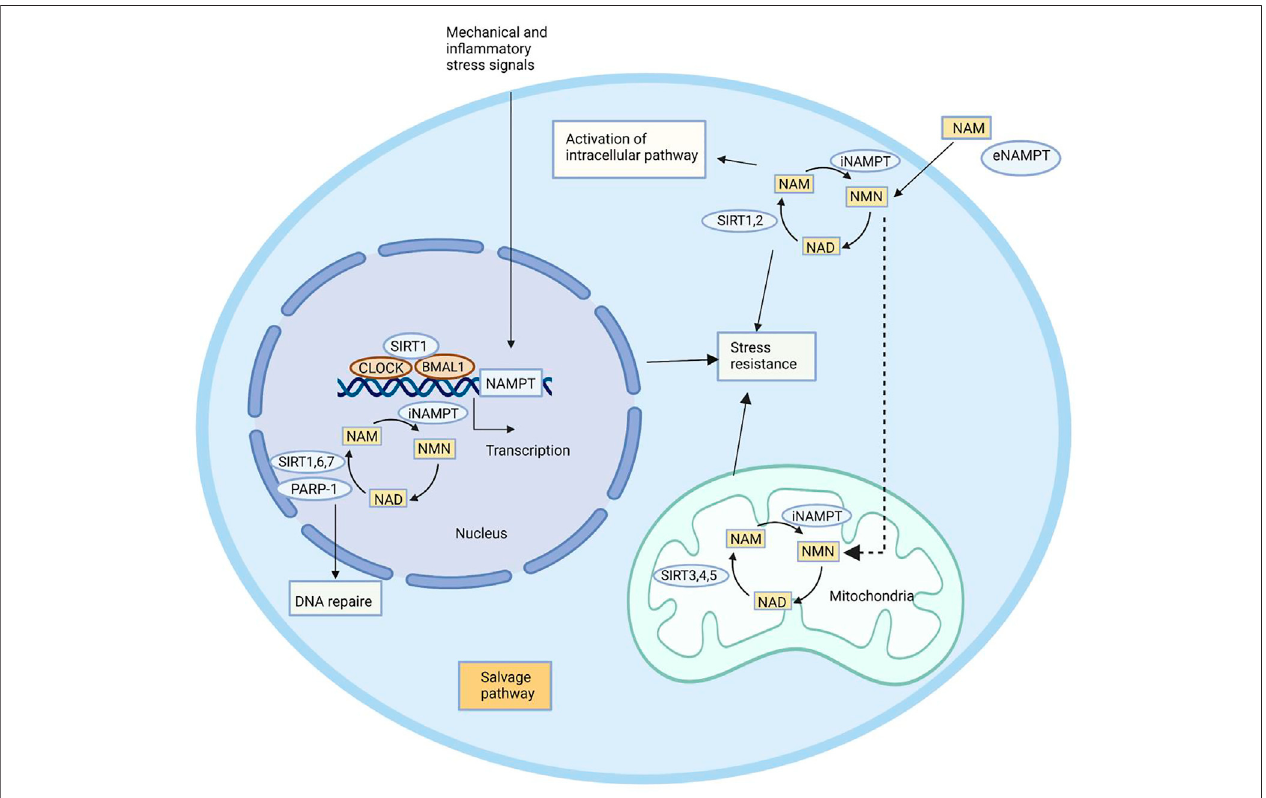
FIGURE 2 | Biological functions of NAMPT. NAMPT plays its role by maintaining intracellular NAD levels and recovering NAM, which is produced by NAD- dependent enzymes PARP-1, SIRT1, SIRT6, and SIRT7 in the nucleus, SIRT1 and SIRT2 in the cytoplasm, and SIRT3, SIRT4, and SIRT5 in the mitochondria. NAMPT expression is induced by circadian regulators CLOCK and BMAL1, which are complex with SIRT1. NAMPT affects a remedial pathway that can resist stress and repair DNA. In addition to enzyme activity, NAMPT can also play an extracellular role in helping NAM produce NMN.